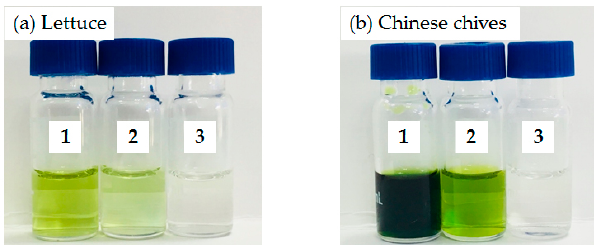
Figure 2. Comparison of the pigment-cleanup e ff ects between Sin-QuEChERS nano and d-SPE methods. ( a ) Extract of lettuce (1) without cleanup, (2) cleaned-up by d-SPE and (3) cleaned-up by Sin-QuEChERS nano. ( b ) Extract of Chinese chives (1) without cleanup, (2) cleaned-up by d-SPE and (3) cleaned-up by Sin-QuEChERS nano.